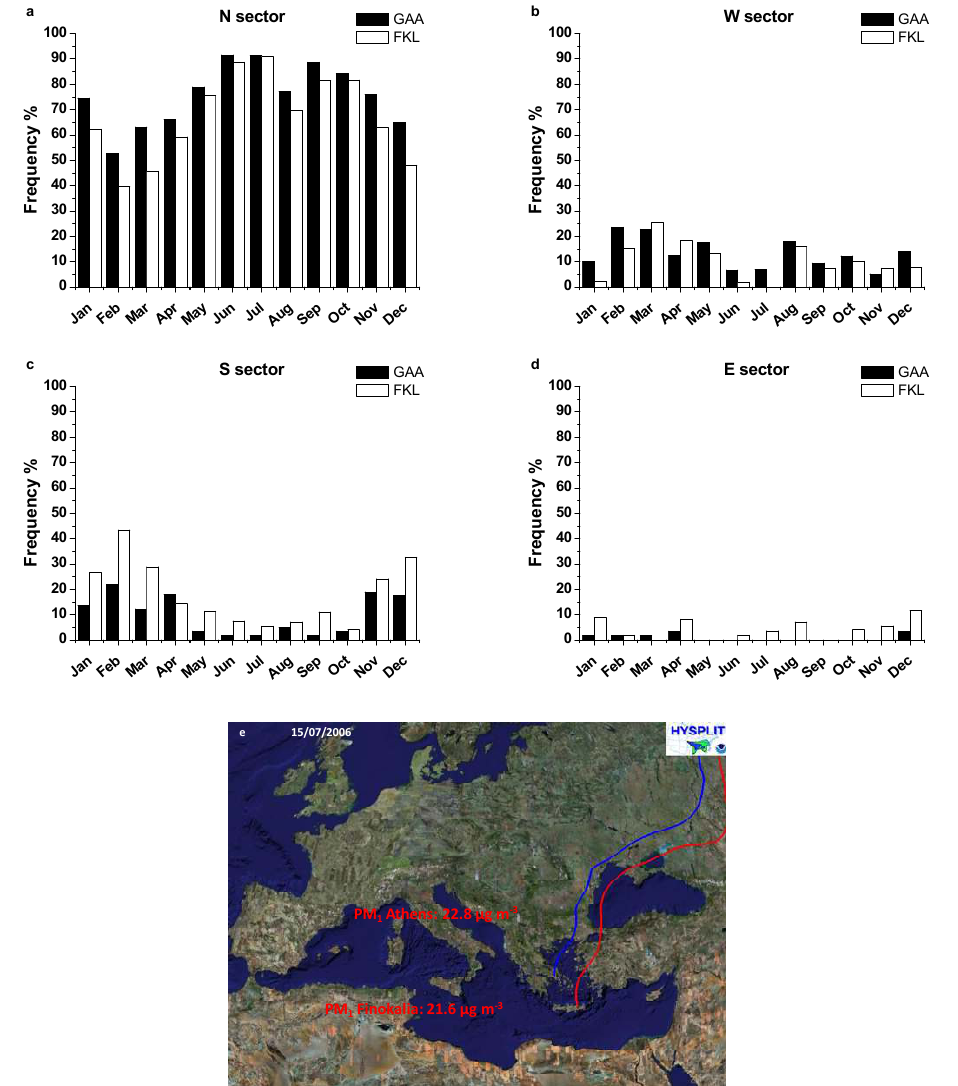
Fig. 2. Yearly-based wind direction occurrences for the 4 sectors (North; a , West; b , South; c and East; d ) at GOU and FKL and a characteristic long range transport influence on PM 1 levels in the studied sites (e)